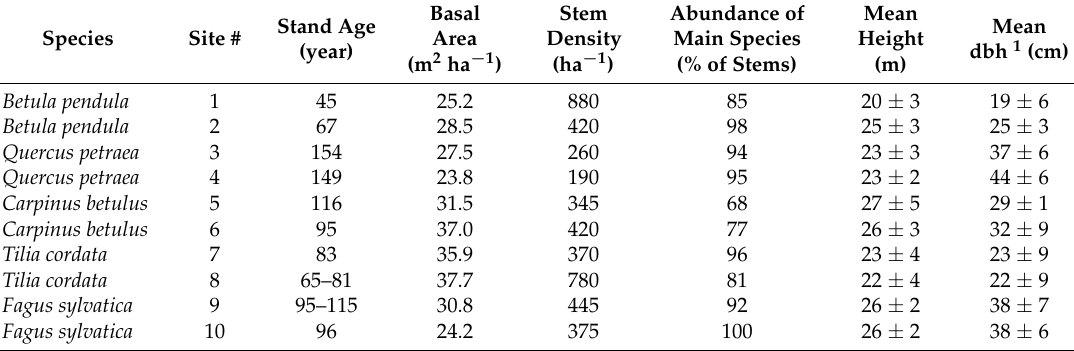
Table 3. Stand structural characteristics of each of the two studied stands of the five species.